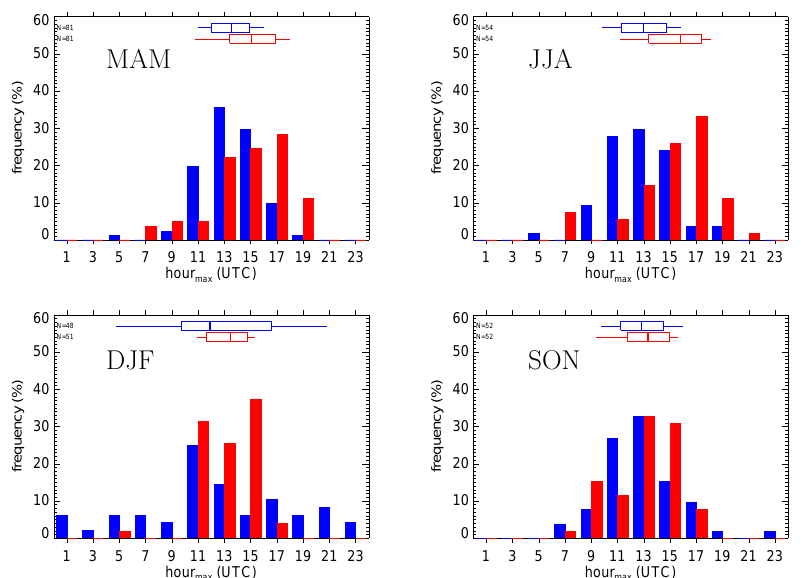
Figure 9. Frequency of occurrence of time of the day when maximum MLH is reached for wind lidar (blue) and ceilometer (red) derived MLH. Clockwise from top left: spring, summer, autumn and winter. Whisker boxes on top show 10, 25, 75 and 90% percentiles and the median.